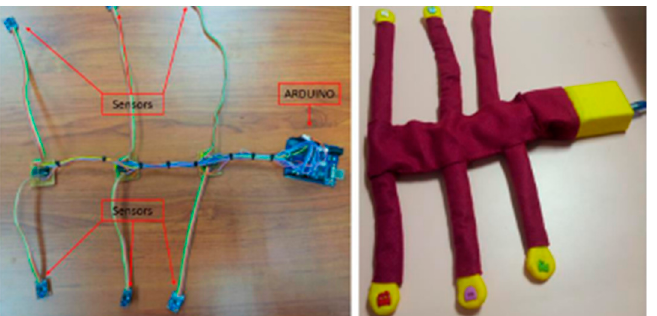
Figure 10. The recording system with six accelerometer sensors and an ARDUINO microcontroller. Open Access [103] © 2022 ARPN—Asian Research Publishing Network.